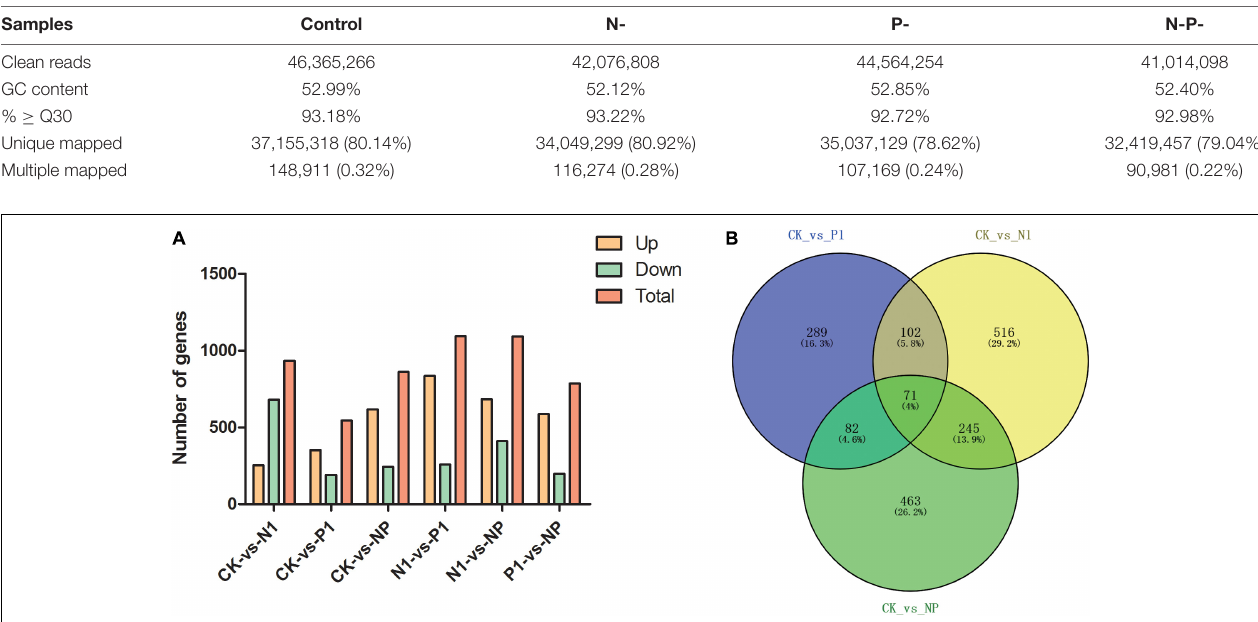
TABLE 3 | Summary of the sequencing data of A. oryzae under nitrogen and phosphorus limitation.